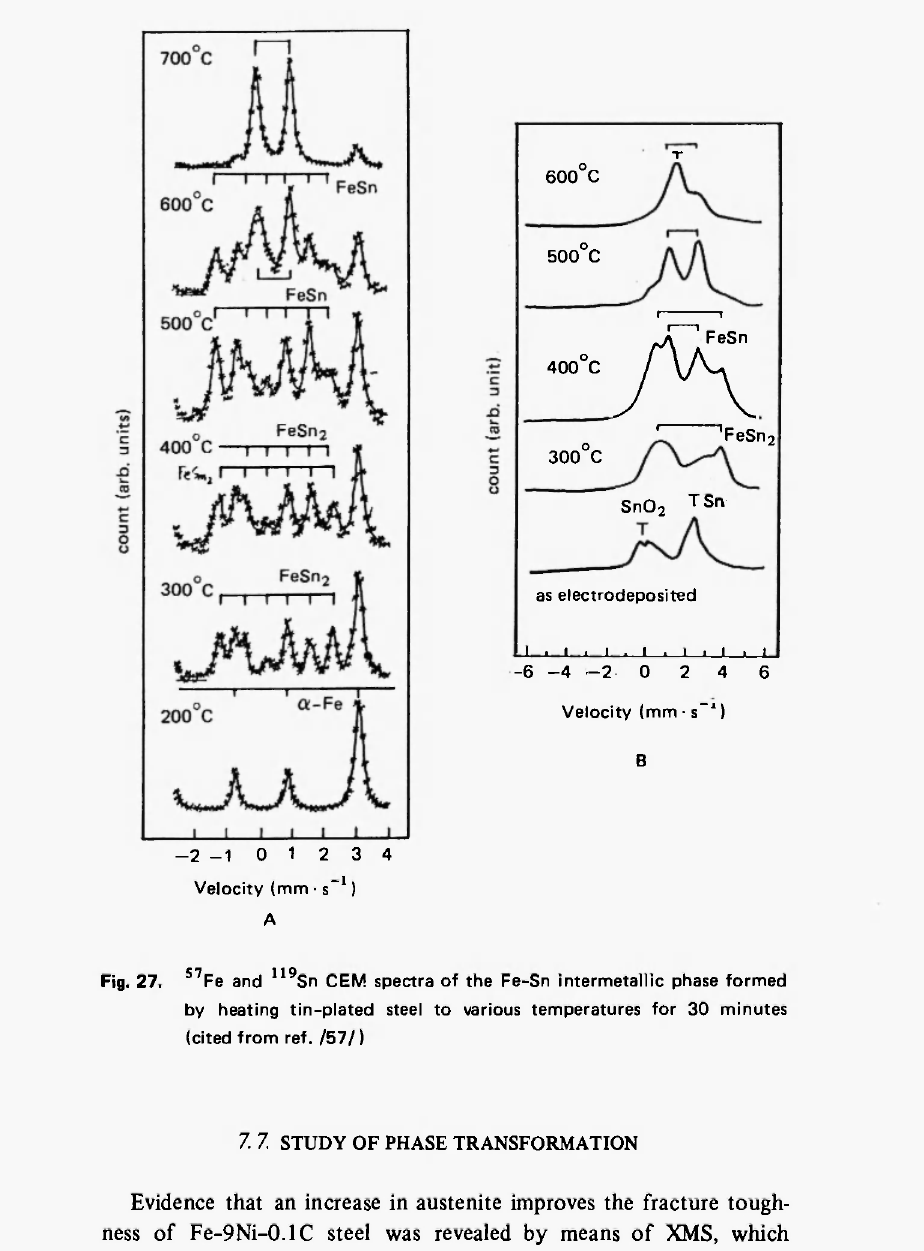
Fig. 27. S7 Fe and u9 Sn CEM spectra of the Fe-Sn intermetallic phase formed by heating tin-plated steel to various temperatures for 30 minutes (cited from ref.